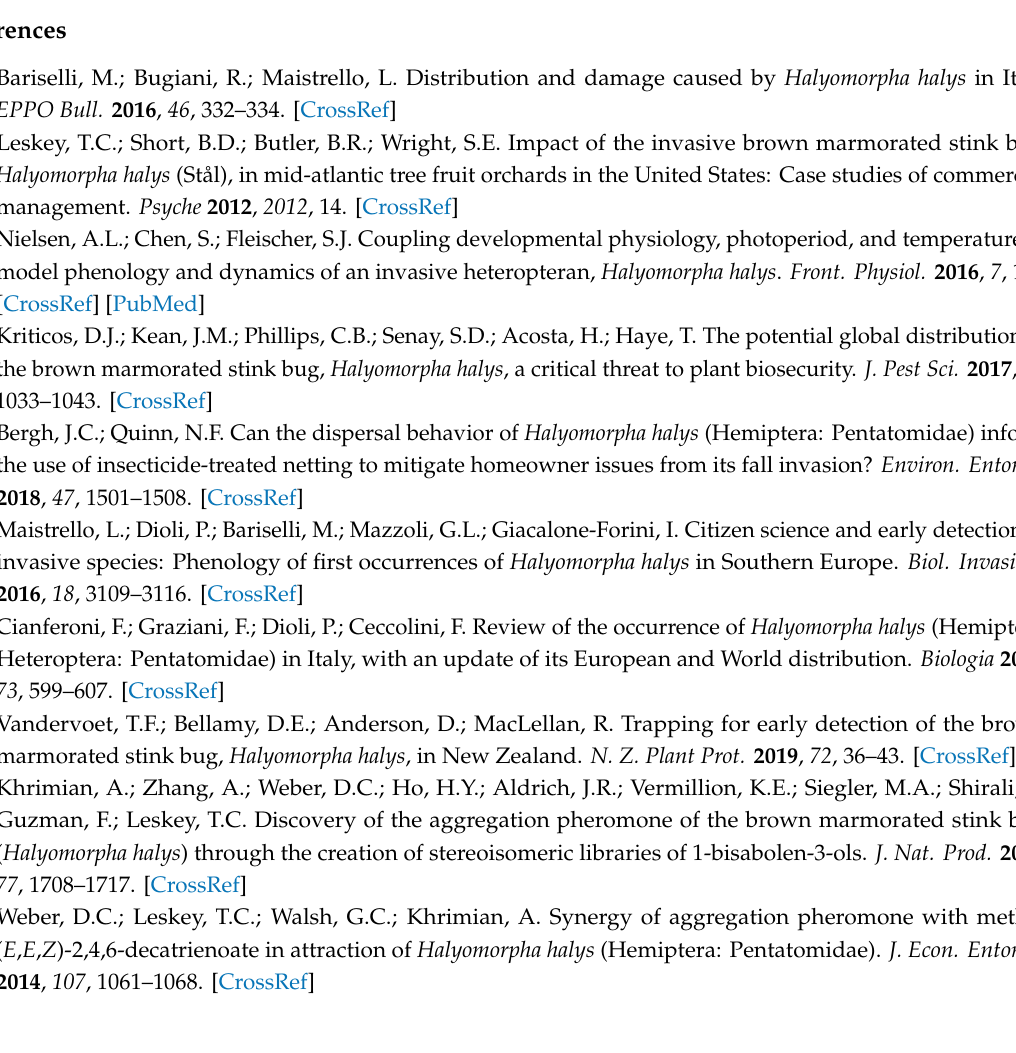
Table S1 : Analysis of variance of log-transformed catch of Halyomorpha halys by trap type and replicate at the forest–vineyard margin in San Michele all’Adige (TN), Italy, from 22 / 8 / 19 to 5 / 9 / 2019, Video S1 : Live Traps for Adult Brown Marmorated Stink